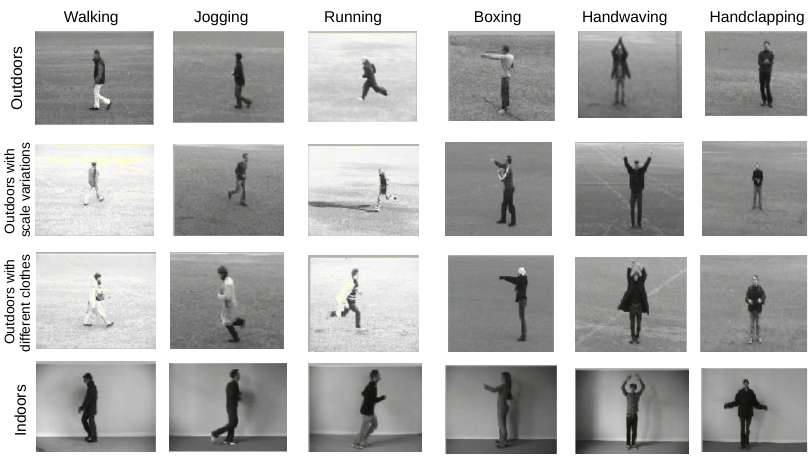
Figure 4. Sample frames of the KTH dataset actions with different